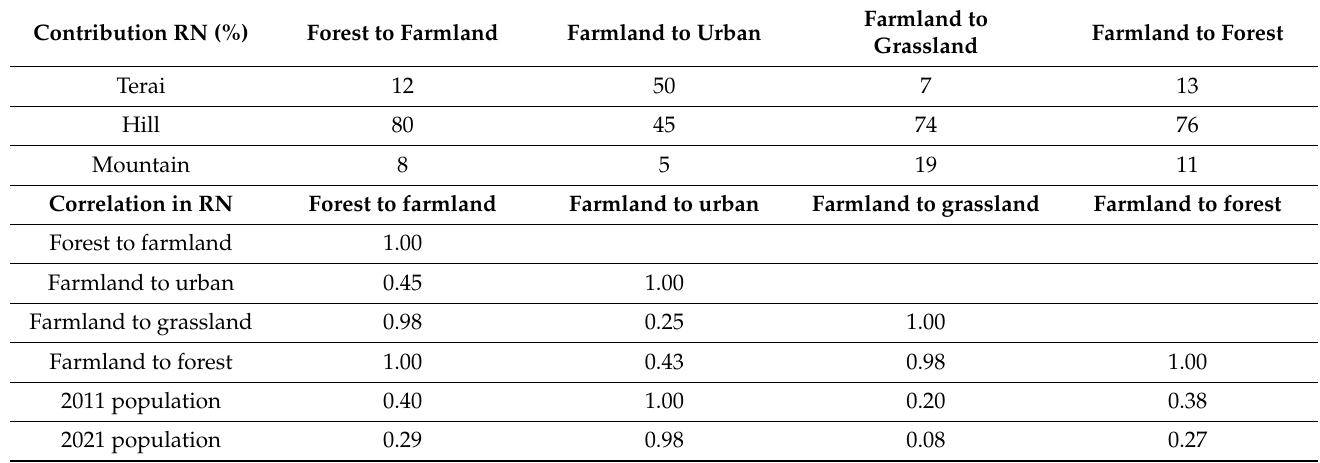
Table 4. Region’s contribution to nation (RN) from 2016 to